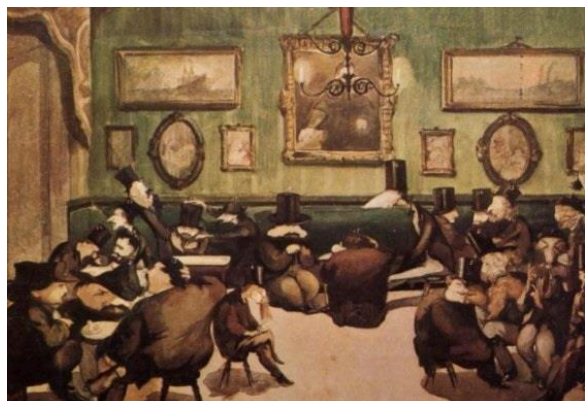
Fig. 22 Il caffé Michelangiolo (Ceccioni,